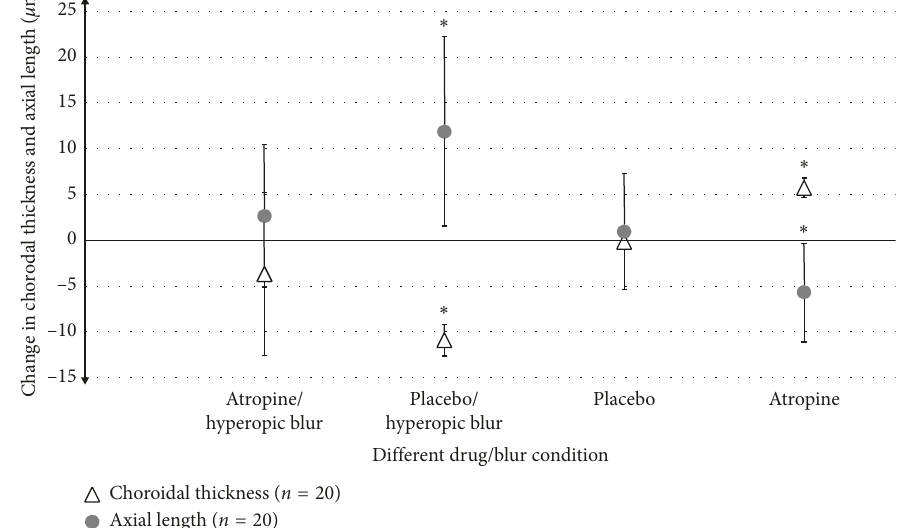
Figure 1: Mean difference in subfoveal choroidal thickness and axial length at 60minutes after the introduction of the four drug and blur conditions for 20 subjects. Asterisks imply significant differences in choroidal thickness and axial length compared to baseline ( p < 0 . 01). Error bars represent ±